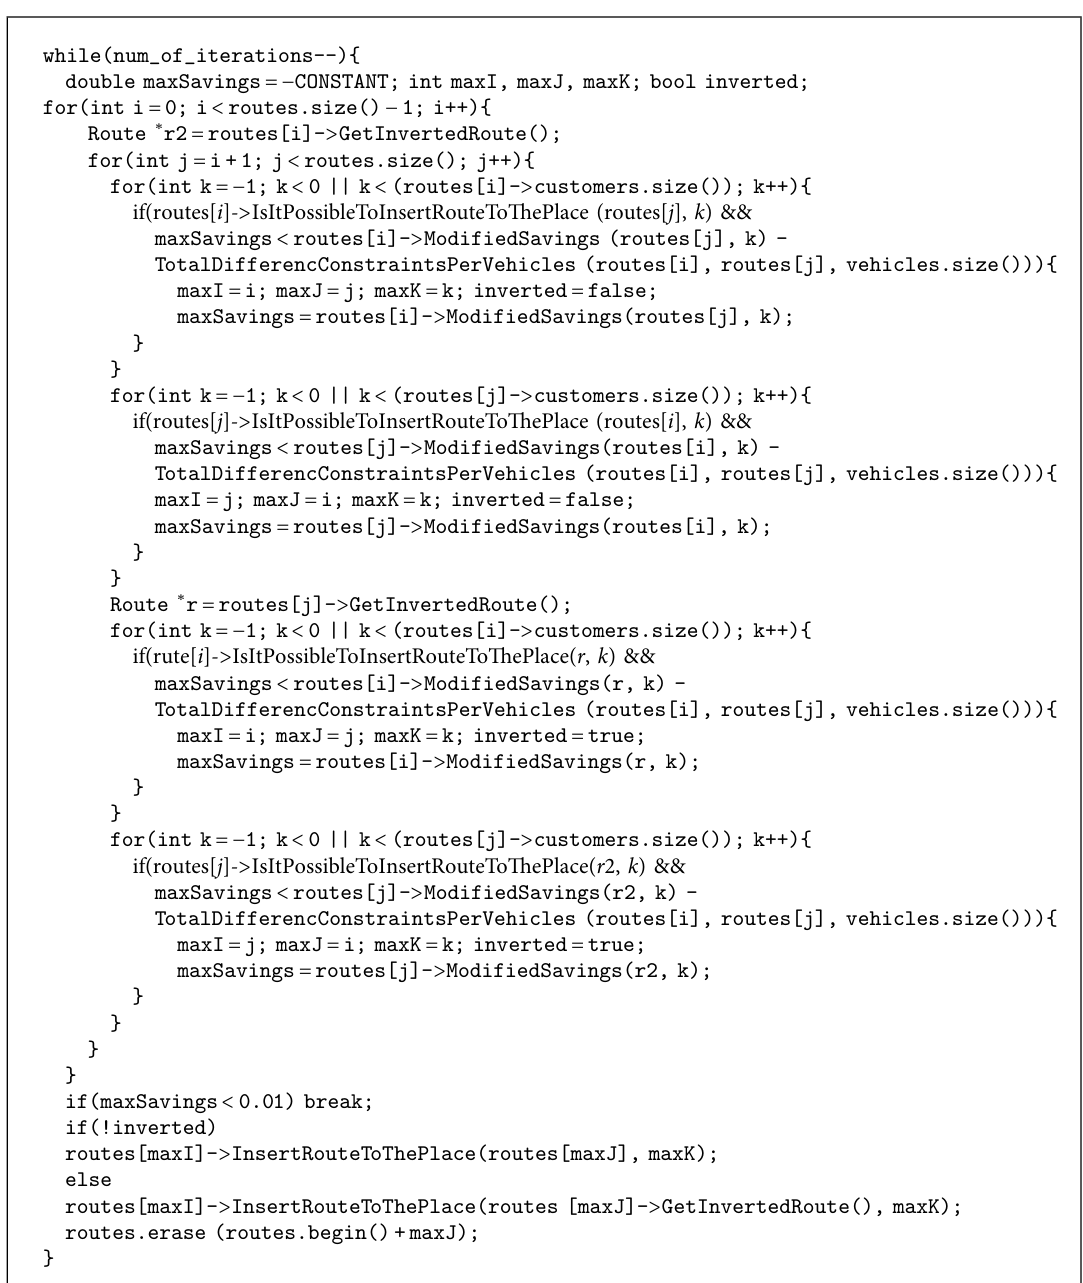
P SEUDOCODE 2: Generation of initial routes using Clarke and Wright savings